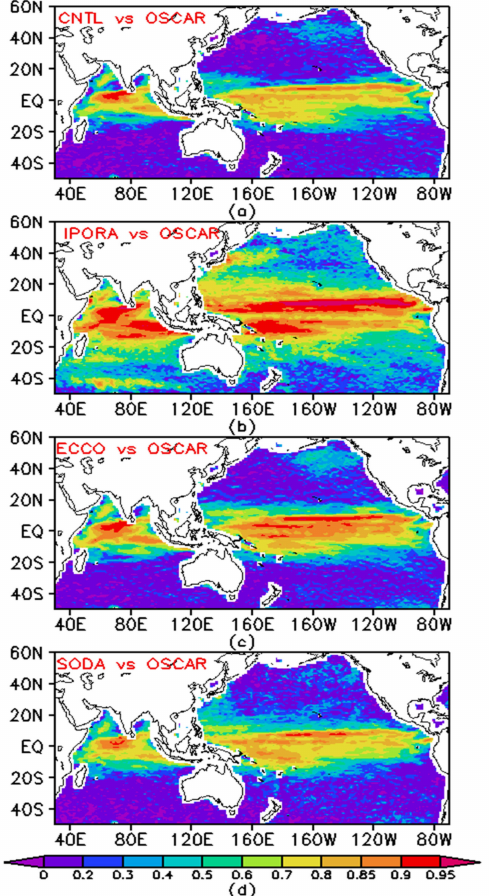
Figure 8. Time correlation with OSCAR surface zonal currents from ( a ) CNTL, ( b ) IPORA, ( c ) ECCO, and ( d ) SODA for the period of